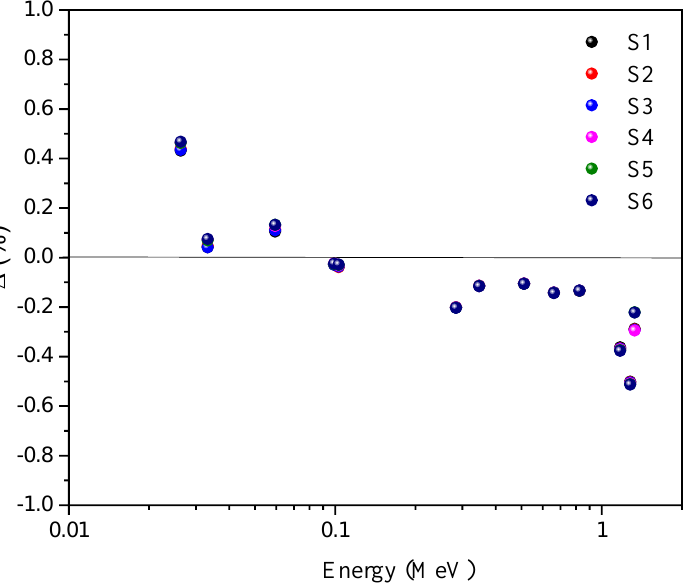
Figure 7. Ratios of MAC values computed by Phy-X against those simulated with the MCNP code. Unlike LAC, the simulated HVL values increase as the incoming gamma photon energy increase (Figure 8). These values demonstrate the ability of the investigated glasses to reduce the incoming gamma photon energy by half. The simulated HVL reached maximum values of 5.2 and 5.08 cm at high gamma energy (1.5 MeV) for S1 and S6. This means that the glasses with low simulated HVL value can be applied as radiation shielding. S6 glasses have low simulated HVL values at the applied range of incoming gamma photon energy (0.0263–1.5 MeV).